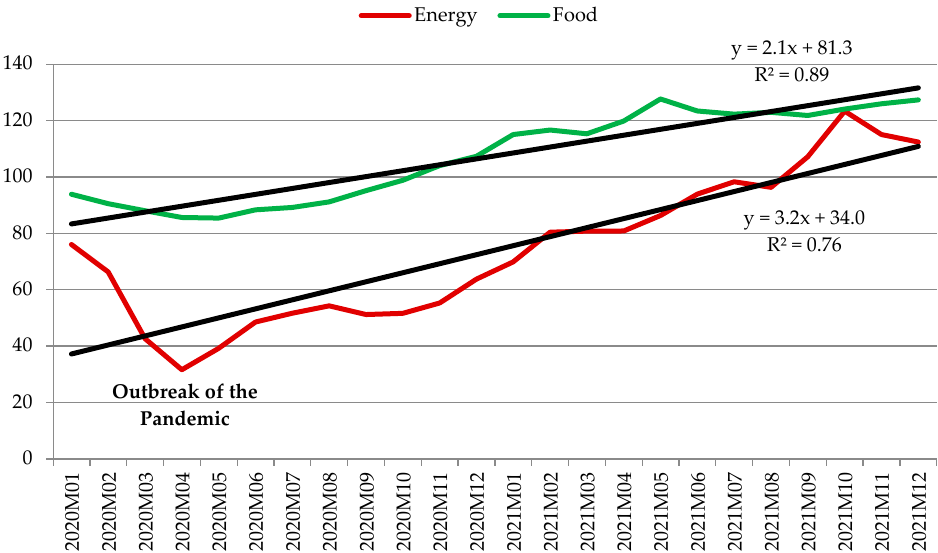
Figure 5. Formation of the monthly world energy and food price indices in 2020–2021.